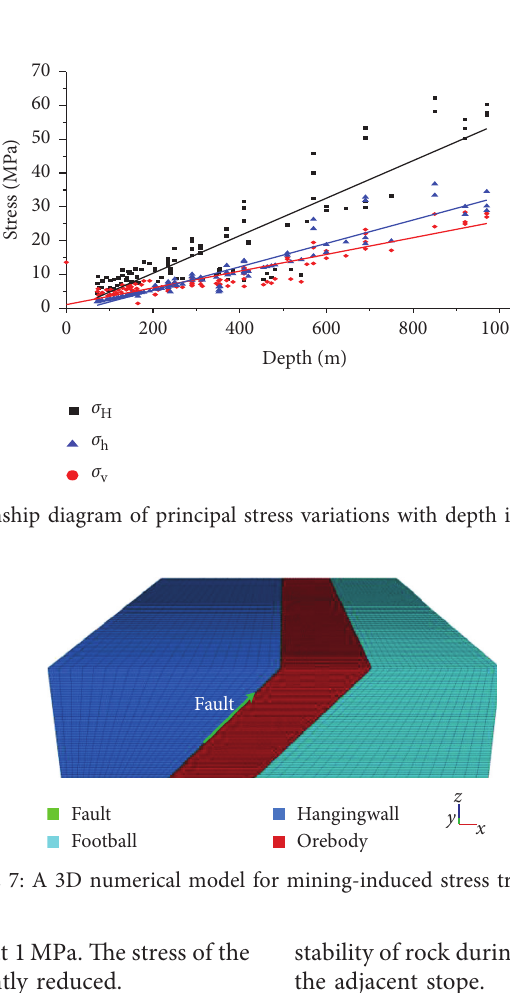
Figure 5: Typical ground failures in deep mining of northwestern Jiaodong. (a) Rockfall, − 870m level, located at SSDF zone. (b) Extruding deformation, − 785m level, located at MRF zone. (c) Rockburst, − 980m level, located at JJF zone. (d) Support failures, − 1070m level, located at ZPF zone.